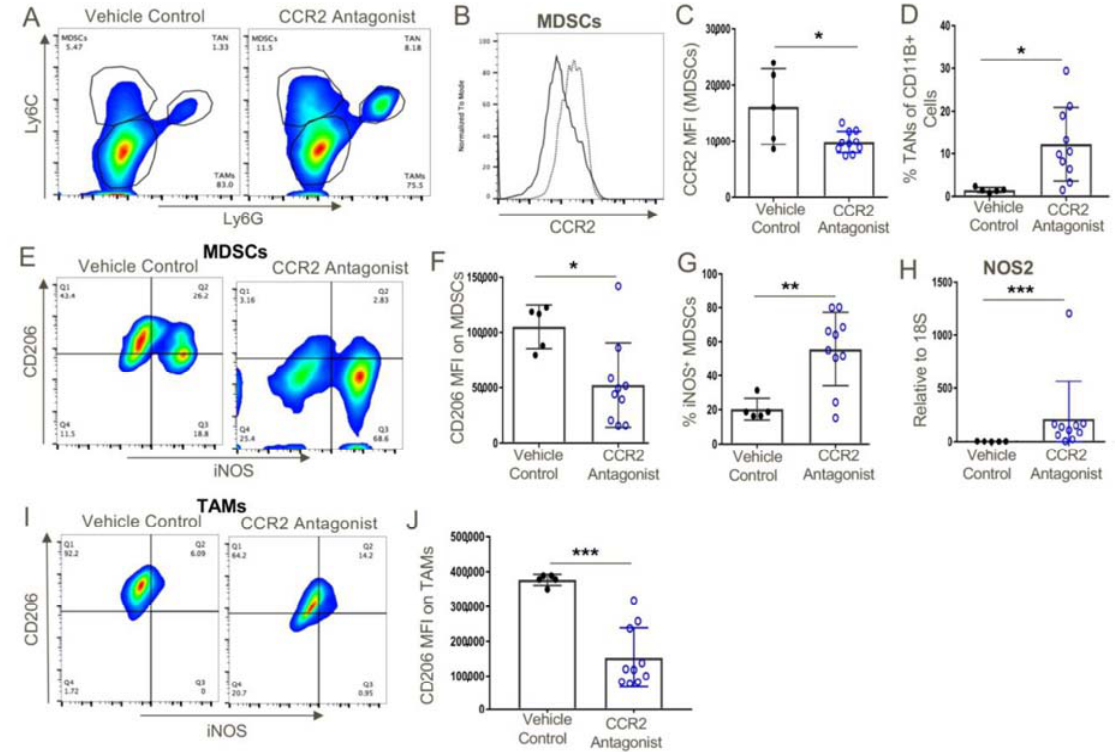
Figure 9. MDSCs within CCR2 antagonist ‐ treated mice expressed significantly lower levels of CCR2 and both MDSCs and TAMs expressed an M1 phenotype as opposed to the M2 phenotype of vehicle control ‐ treated mice. ( A ) Intratumoral analysis post ‐ therapy with vehicle control or CCR2